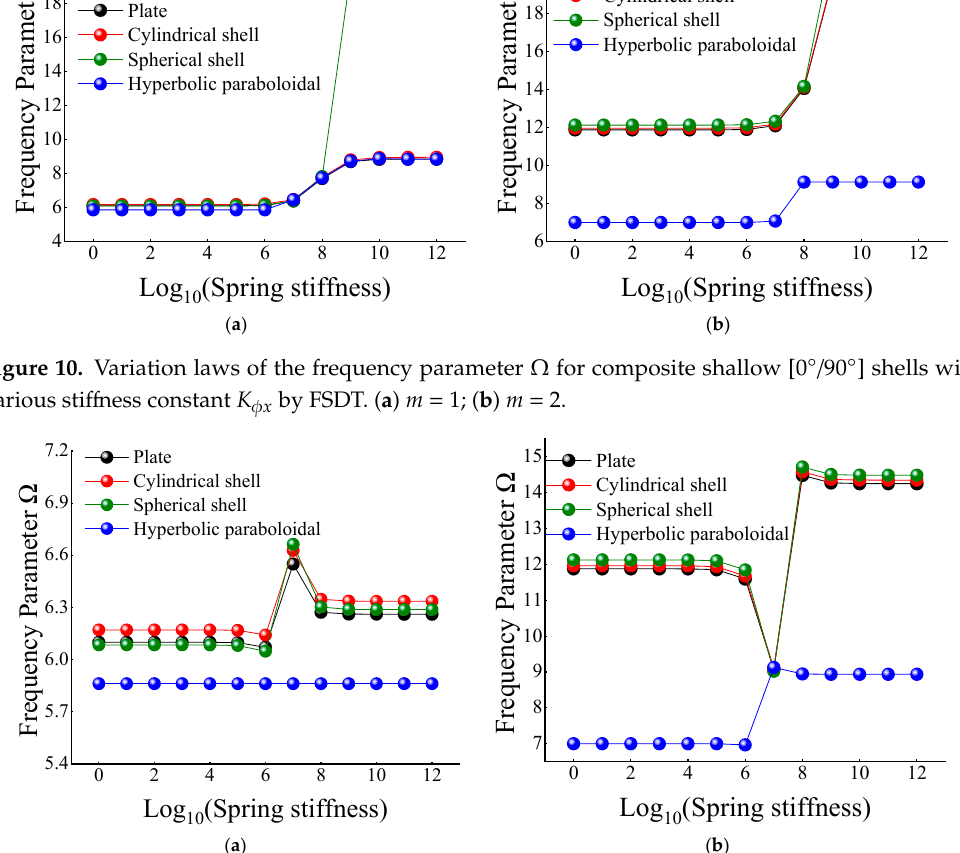
Figure 11. Variation laws of the frequency parameter Ω for composite shallow [0 ° /90 ° ] shells with various stiffness constant K ϕ y by FSDT. ( a ) m = 1; ( b ) m = 2.